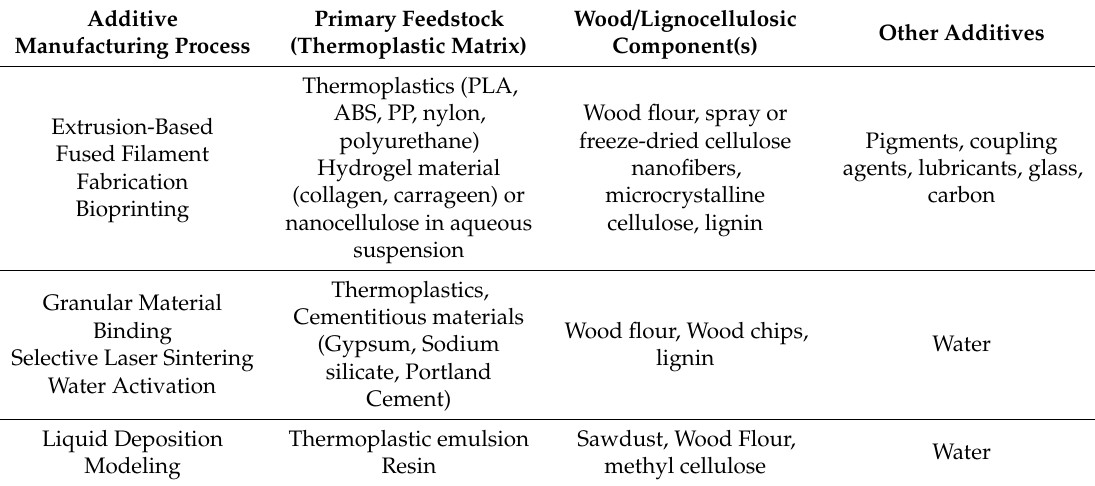
Table 1. Additive Manufacturing processes utilizing wood and lignocellulosic-based materials.